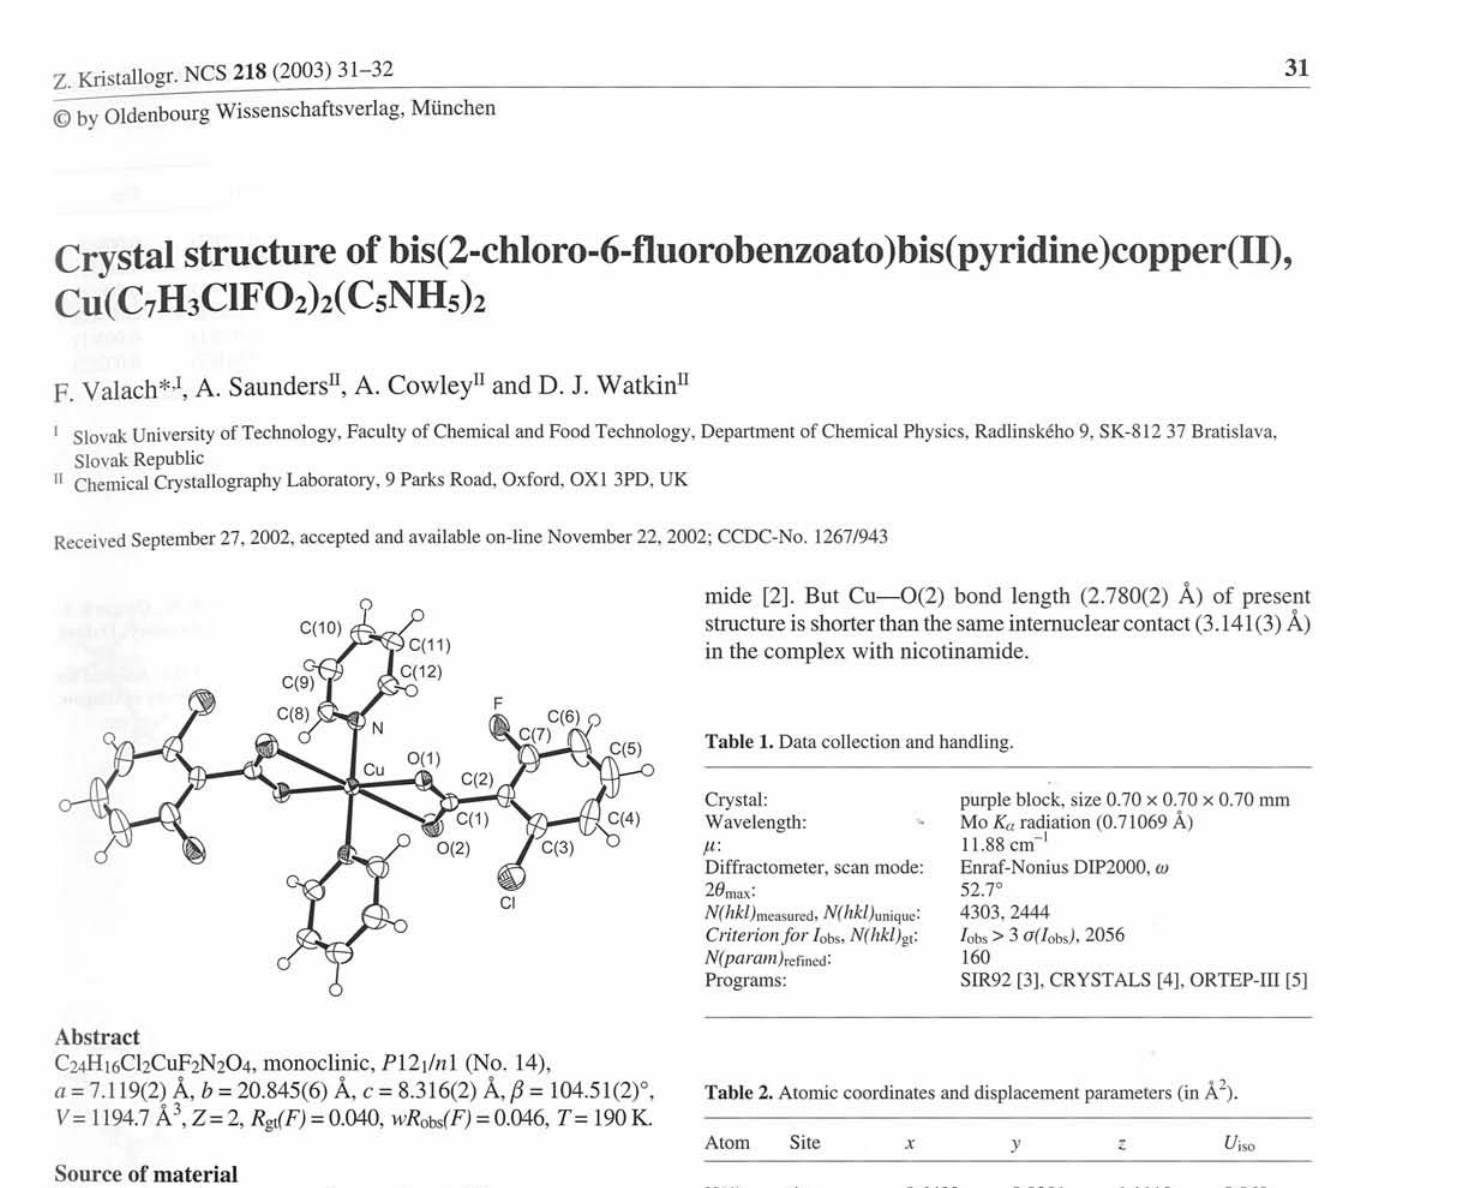
Table 3. Atomic coordinates and displacement parameters (in Â 2